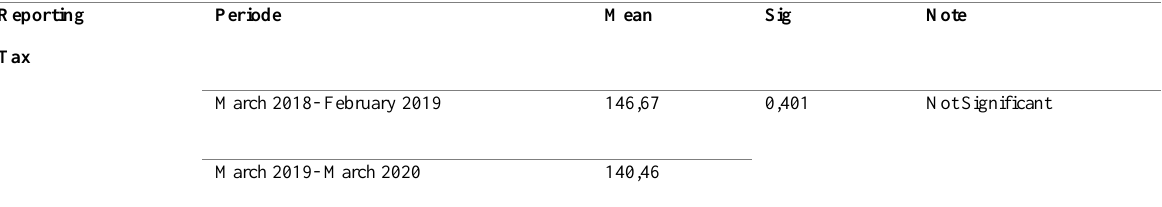
Table 3: Result of Hypothesis Three